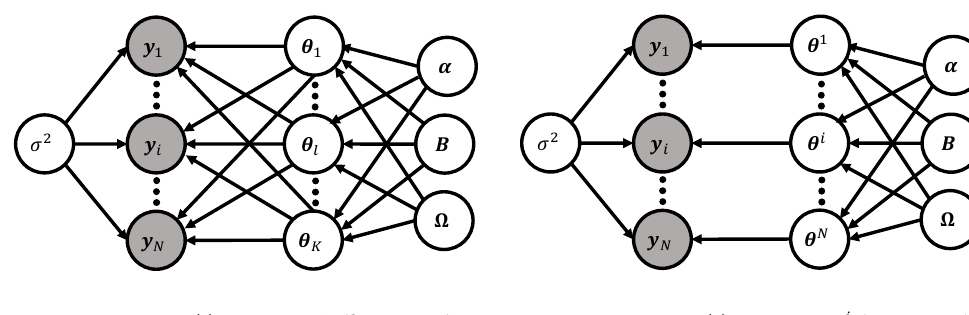
Figure 9. DAG representations of the basic model (2)–(4) in vector-form (a) (Stage 1—(6), Stage 2—(7) ( l -indexing), and Stage 3—(9)) ( left ) and vector-form (b) (Stage 1—(6), Stage 2 (cid:48) —(8) ( i -indexing), and Stage 3—(9)) ( right ). Two vector forms are equivalent, except for the way how the model matrix Θ (5) is